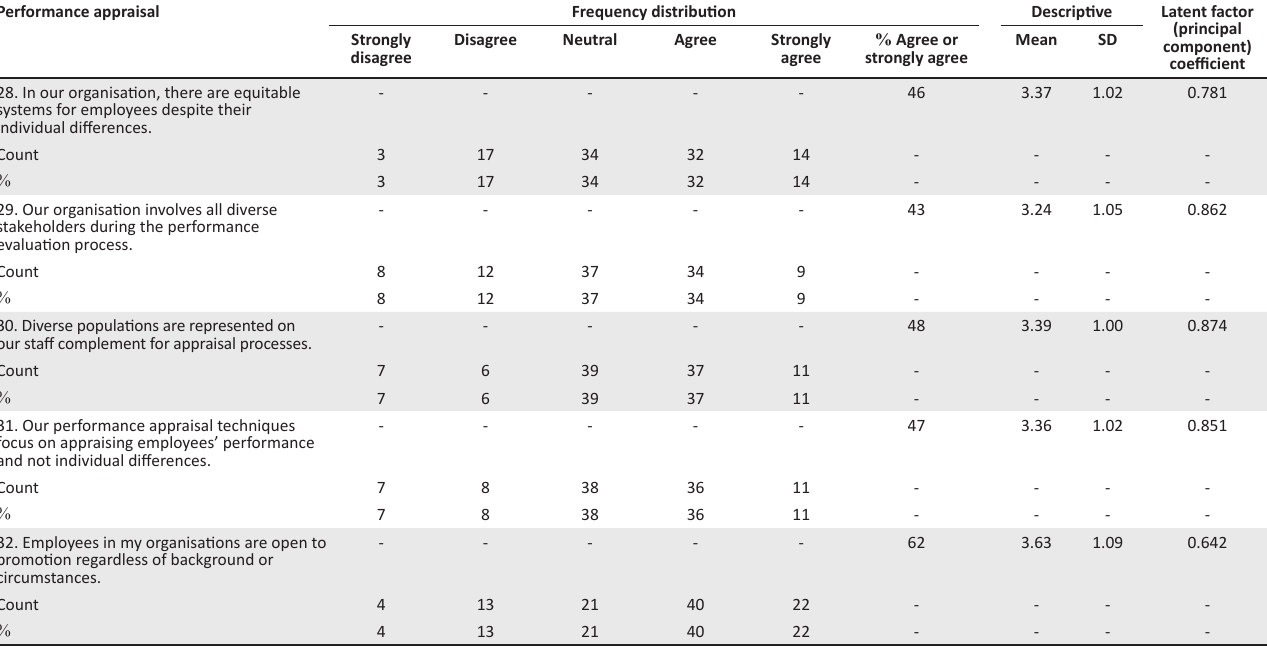
TABLE 9: Analysis of the construct of performance appraisal. Performance